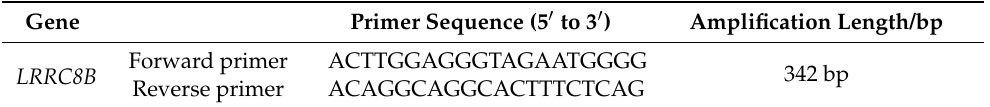
Table 1. Primer information.